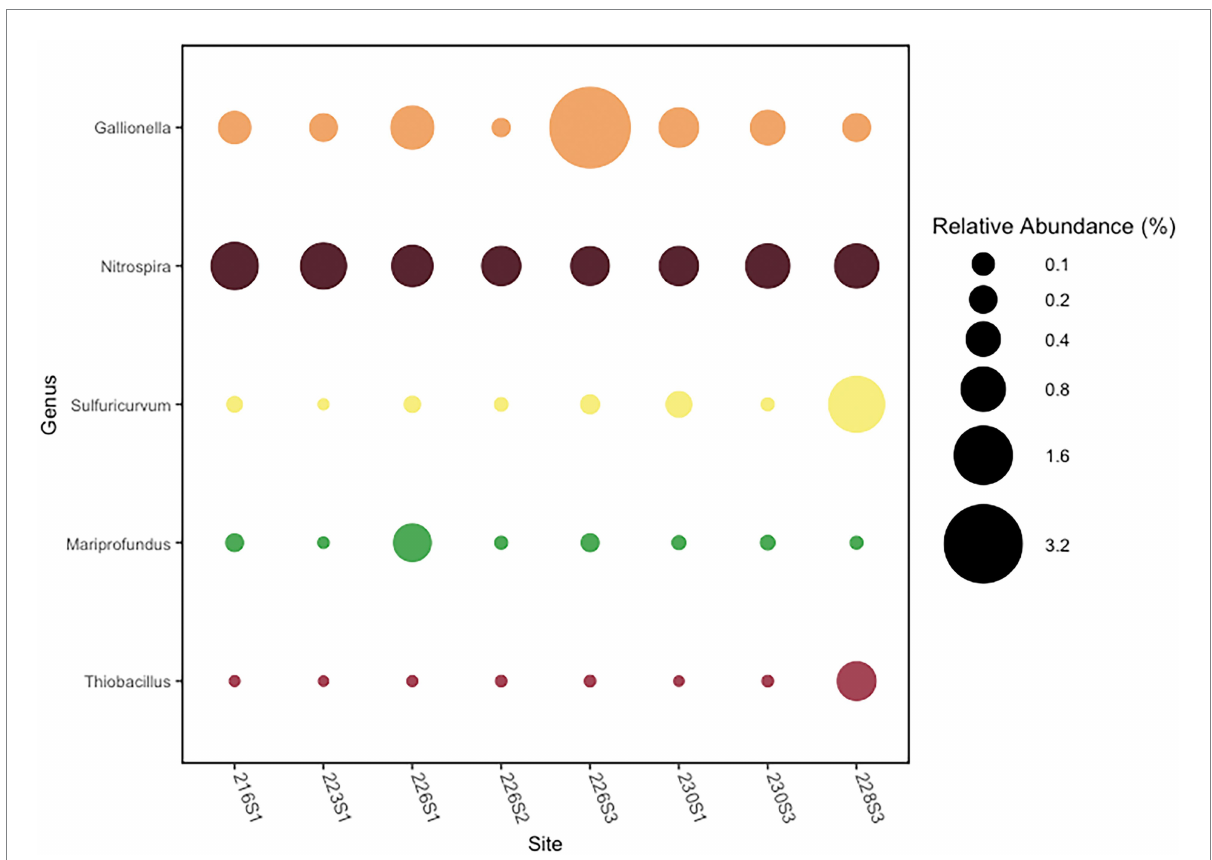
FIGURE 4 Relative abundance of putative chemoautotrophic genera with a maximum abundance >0.5% of reads in at least one